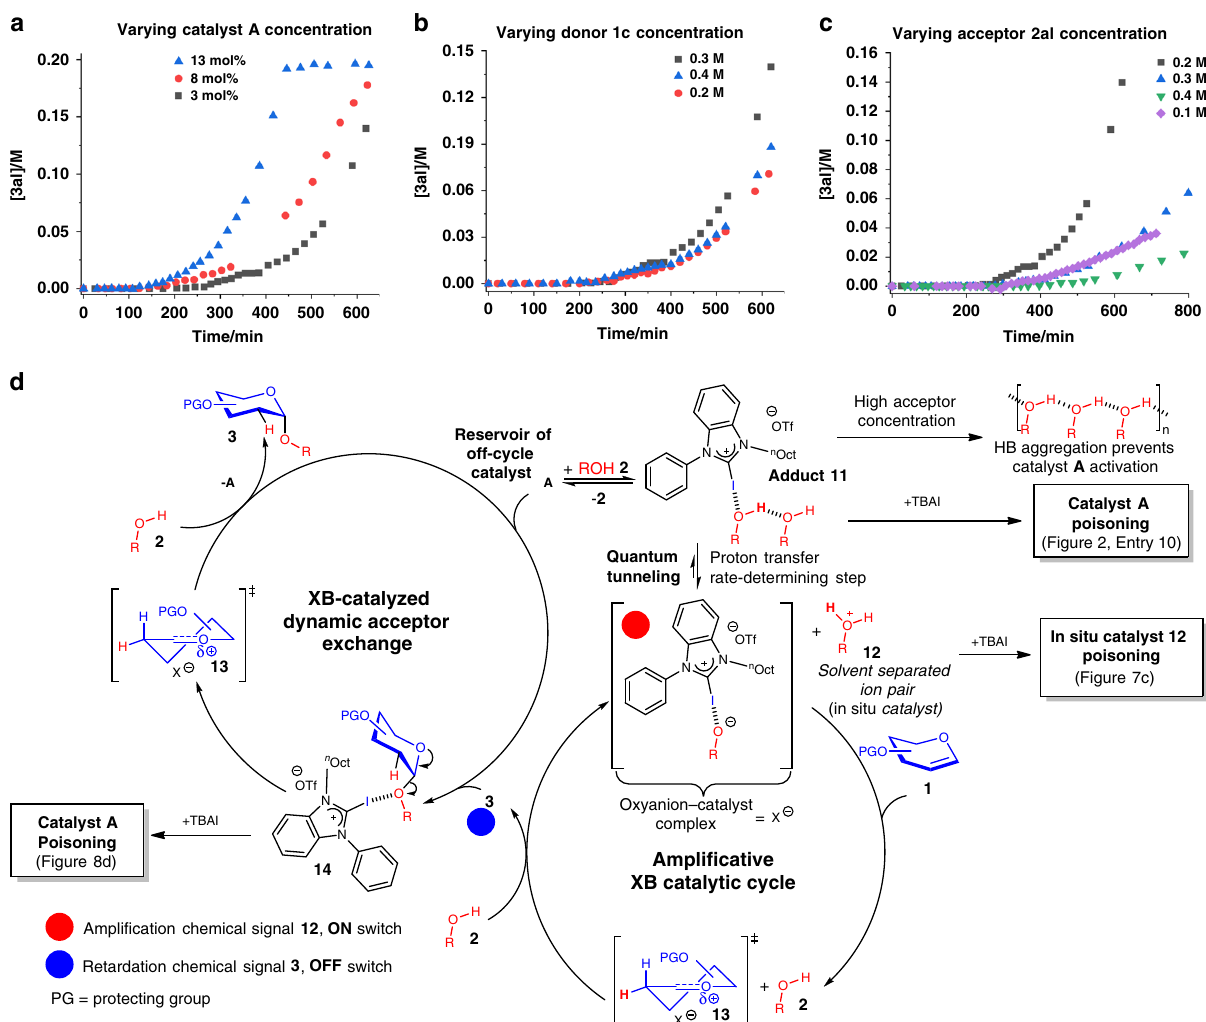
Fig. 9 Reaction mechanism. a Varying catalyst A concentration on the kinetic pro fi le, b varying donor 1c concentration on the kinetic pro fi le, c varying acceptor 2al concentration on the kinetic pro fi le, d proposed mechanism of XB-catalyzed 2-deoxyglycosylation through an XB-modulated intricate reaction